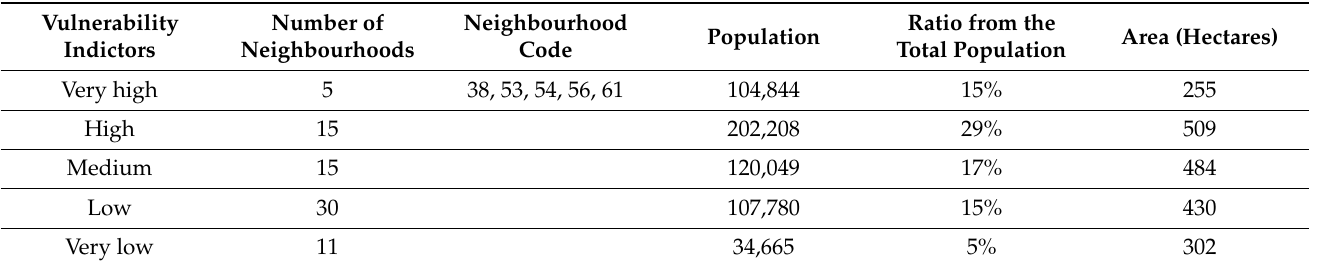
Table 9. Second classification scenario of city neighborhoods based on the comprehensive vulnerabil- ity index (Vt).